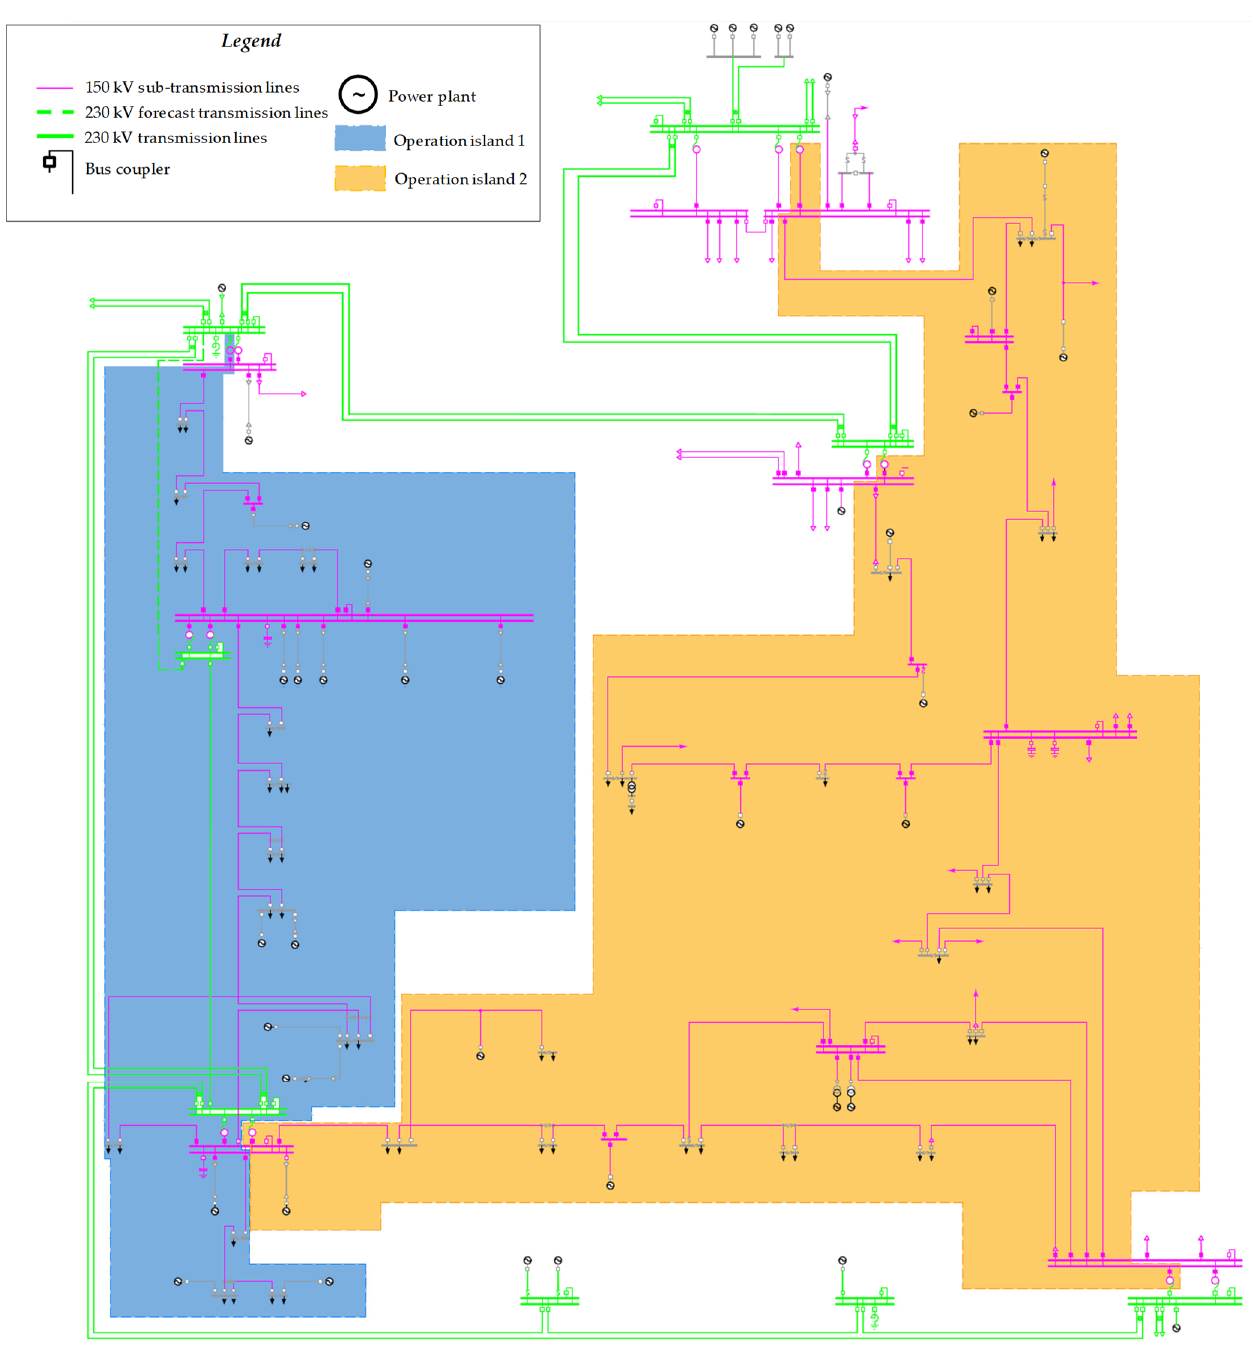
Figure 10. Operation islands in a specific portion of Sicilian 150 kV subtransmission network.